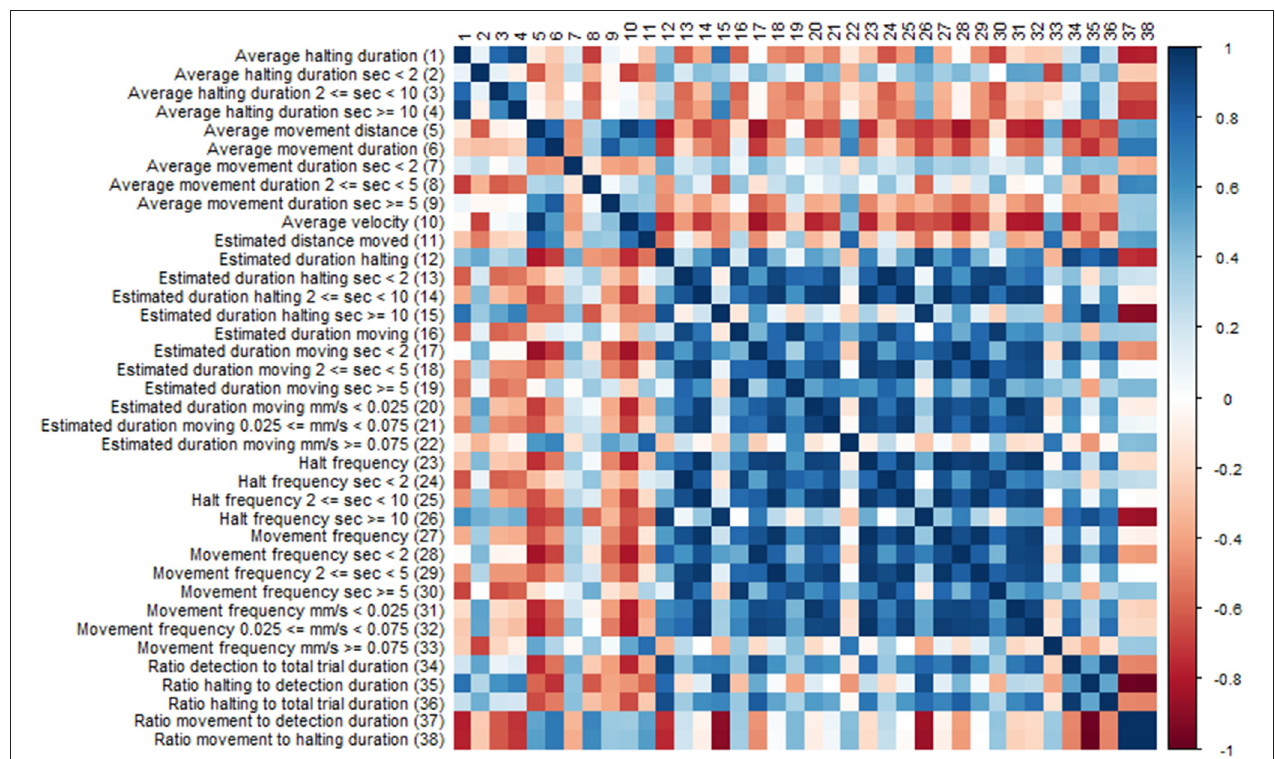
FIGURE 5 | Correlation diagram of behavior statistics. Colors indicate spearman Rho correlation values, where blue boxes indicate positive correlations and red boxes negative correlations between